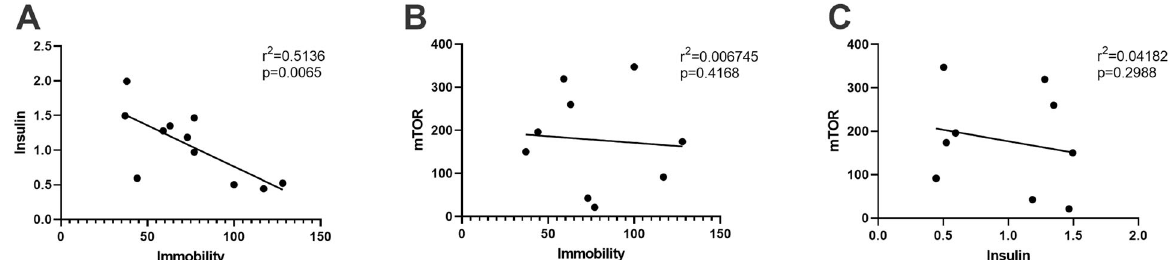
Fig. 5 Correlation between antidepressant-like response and peripheral blood markers. A signi fi cant negative correlation was observed between levels of insulin in peripheral blood (plasma) and time spent immobile in the forced swim test in animals receiving both ketamine and lithium ( A ). No linear relationship was observed for peripheral levels of mTOR and immobility time ( B ), nor for peripheral mTOR and insulin ( C ). mTOR mammalian target of